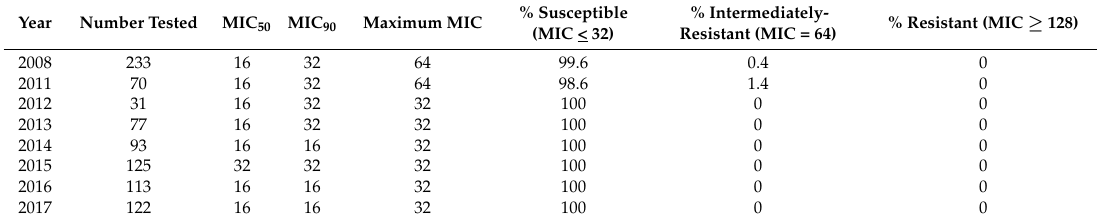
Table 6. Spectinomycin MIC trend analysis, Johannesburg,